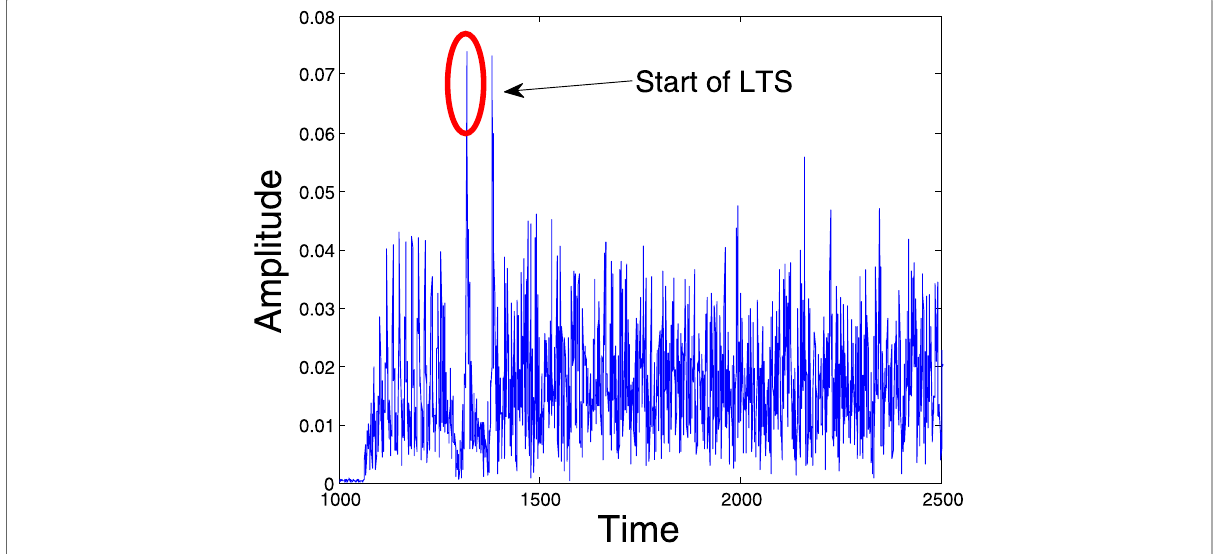
Fig. 14 Symbol synchronization by using modified